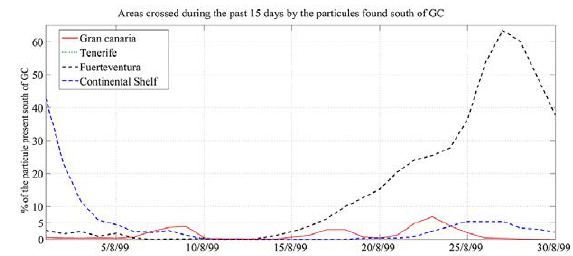
Fig. 10. – Contribution of Gran Canaria, Tenerife, Fuerteventura islands coastal area and the African continental shelf to the particles sampled south of Gran Canaria. Note that the Tenerife contribution was